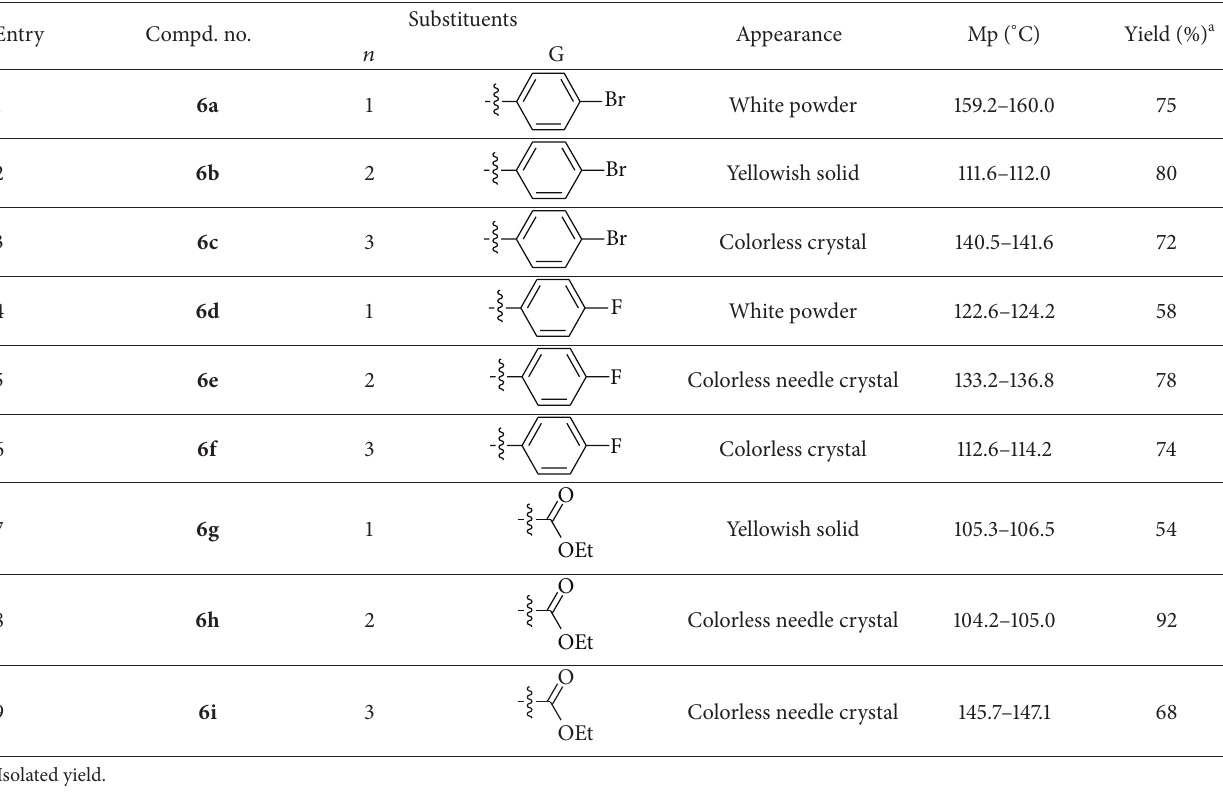
Table 1: The chemical structure of salicylamide derivatives 6a–i .